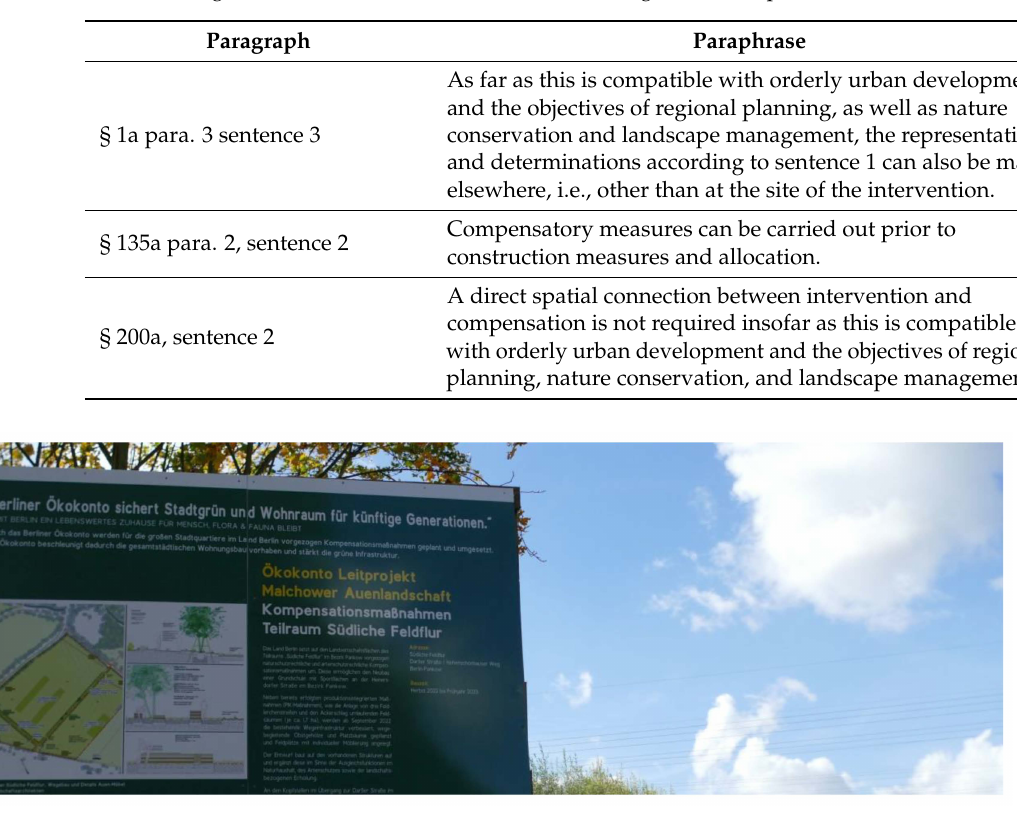
Figure A1. Information for the public: eco-account flagship project, Malchow wetland landscape, compensation measures in subarea “Südliche Feldflur”: (Oct. 2022, G.F.M.